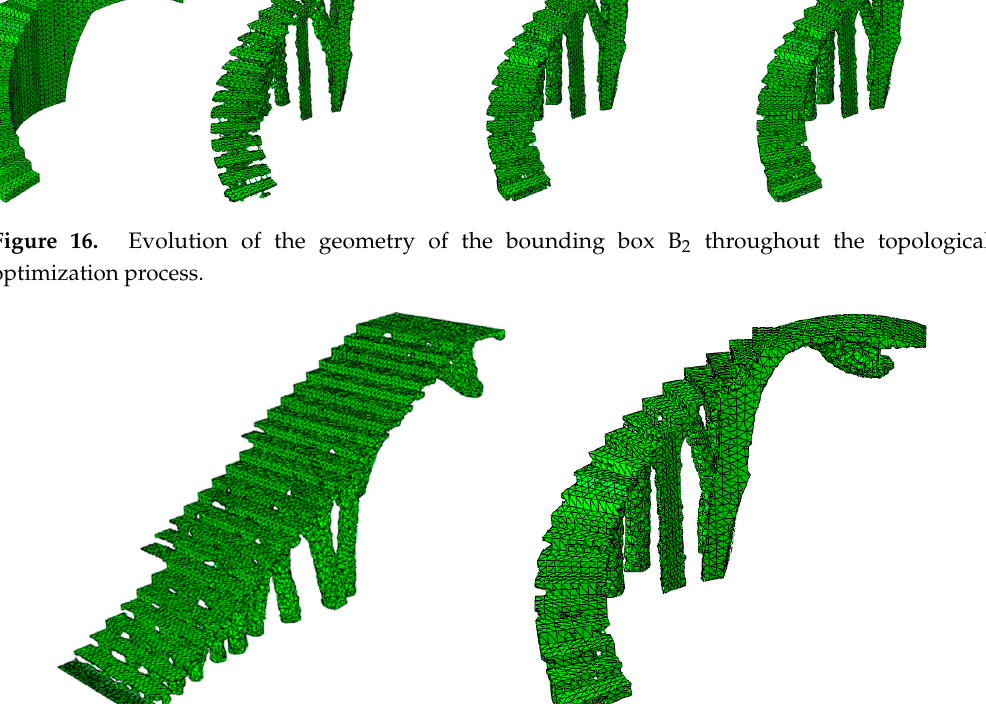
Figure 17. Final result of the optimization algorithm for the bounding boxes B 1 ( left ) and B 2 ( right ).